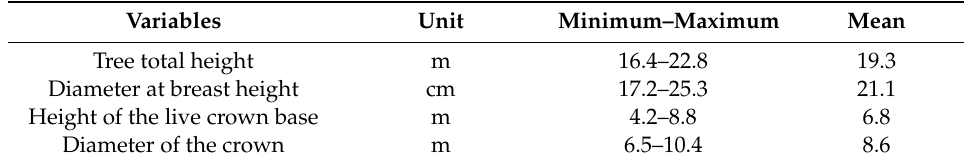
Table 2. Summary tree statistics.